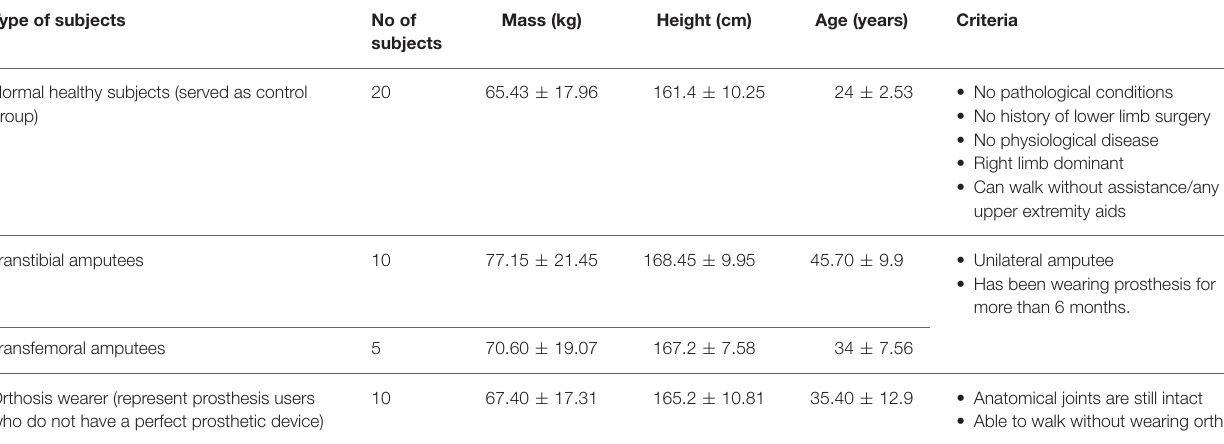
TABLE 1 | Description of the subjects. Type of subjects